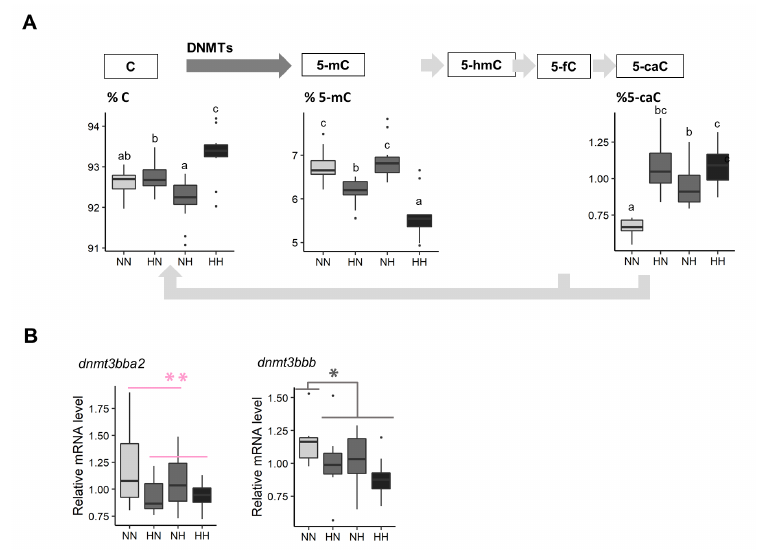
Figure 5. Effect of parental HC/LP on fry epigenetic landscape. ( A ) Proportion of intermediates of DNA methylation in their offspring and ( B ) relative mRNA levels of two homologs coding for Dnmt3, an enzyme involved in the maintenance of DNA methylation patterns. The effect of the maternal nutritional history is depicted in red and the effect of both the maternal and the paternal nutritional history in grey (”*” means p -value < 0.05). Different letters indicate significant differences between groups, which were investigated with a Tukey post hoc test, in the case of a significant interaction between the paternal and the maternal nutritional